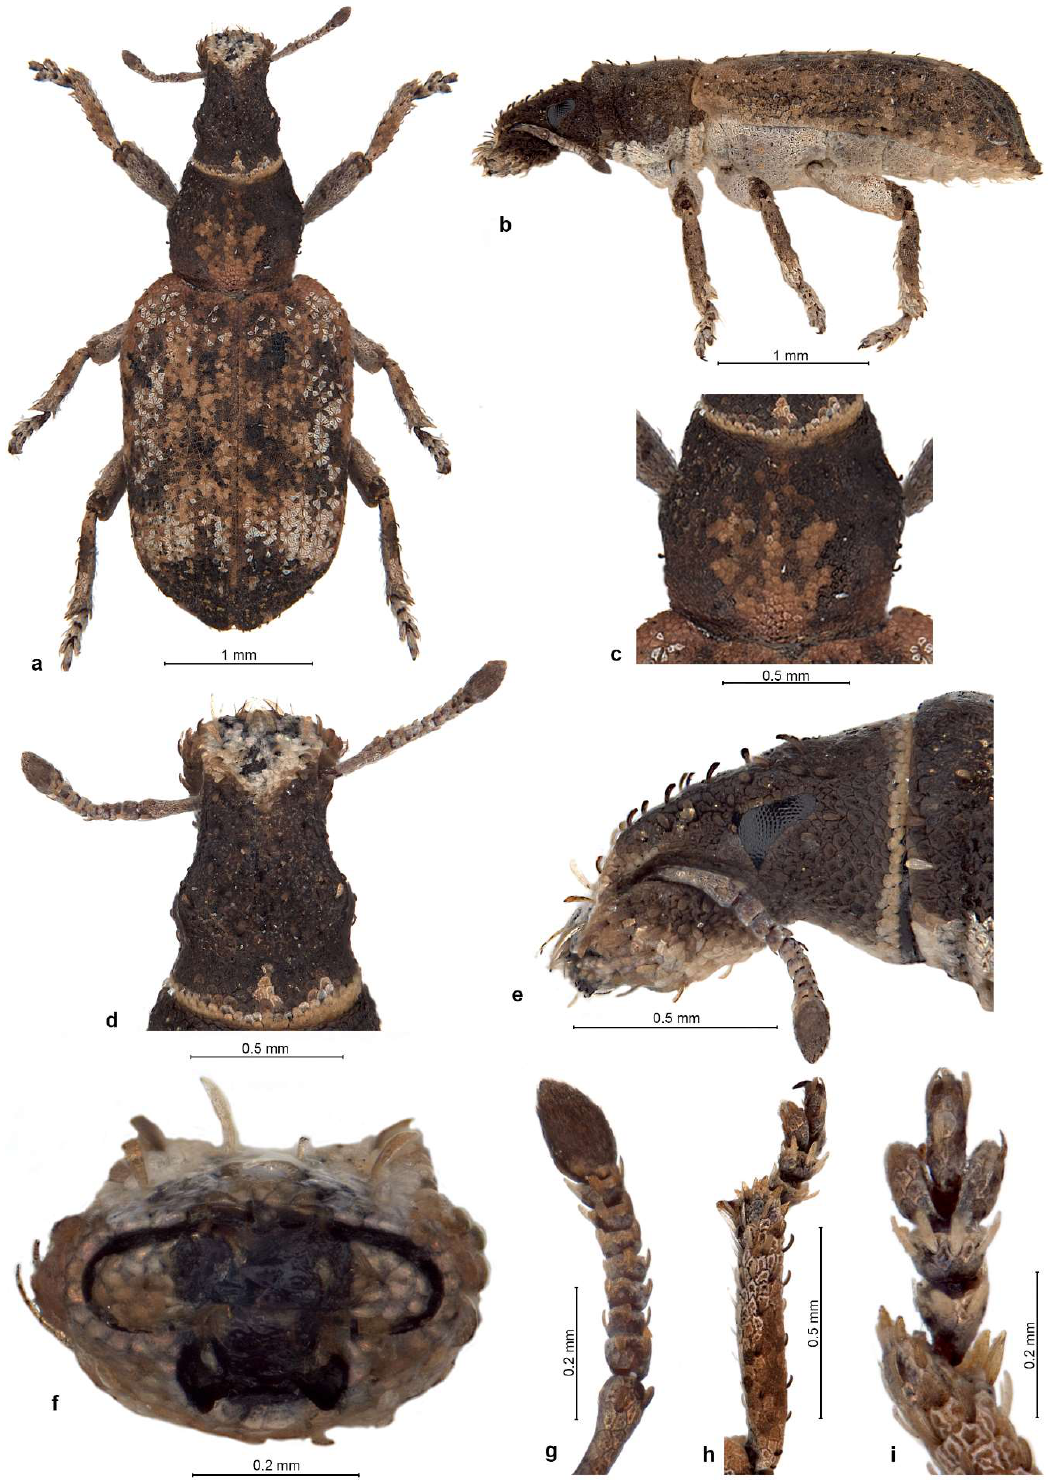
Figure 2. Philetaerobius nidicola Marshall ( Gannapoort), ♂ —dorsal habitus ( a ); left lateral habitus ( b ); pronotum, dorsal view ( c ); head, dorsal view ( d ); head, lateral view ( e ); rostrum, frontal view ( f ); right antenna, dorsal view ( g ); right protibia and -tarsus, dorsal view ( h ); right protarsus, dorsal view ( i ).